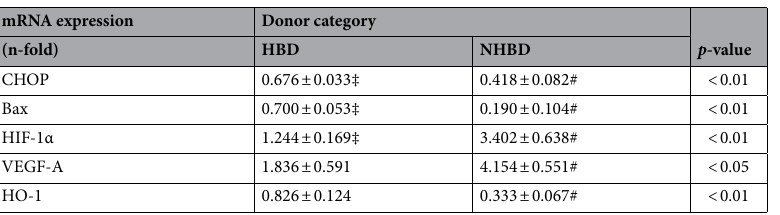
Table 1. Effect of hypoxic preconditioning on mRNA expression of cultured rat islets isolated from heart- beating (HBD, n = 7) or non heart-beating (NHBD, n = 7) donors. mRNA expression is displayed as n-fold change compared with sham-treated islets and was measured by qRT-PCR after 24 h of culture in hypoxia. † p < 0.05, ‡ p < 0.01, # p < 0.001 versus corresponding sham-treated.